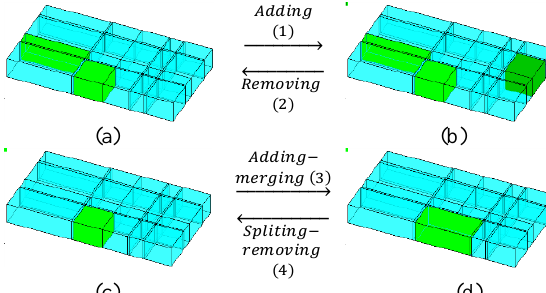
Fig. 3 Examples of transitions between two models in the model space of an interior space. Adding: from (a) to (b) by adding a navigable shape (dark green). Removing: from (b) to (a) by removing a navigable shape (dark green). Adding and merging: from (c) to (d) by adding a navigable shape and merging it with the adjacent space. Splitting and removing: from (d) to (c) by splitting a merged navigable space and nulling the semantics of one